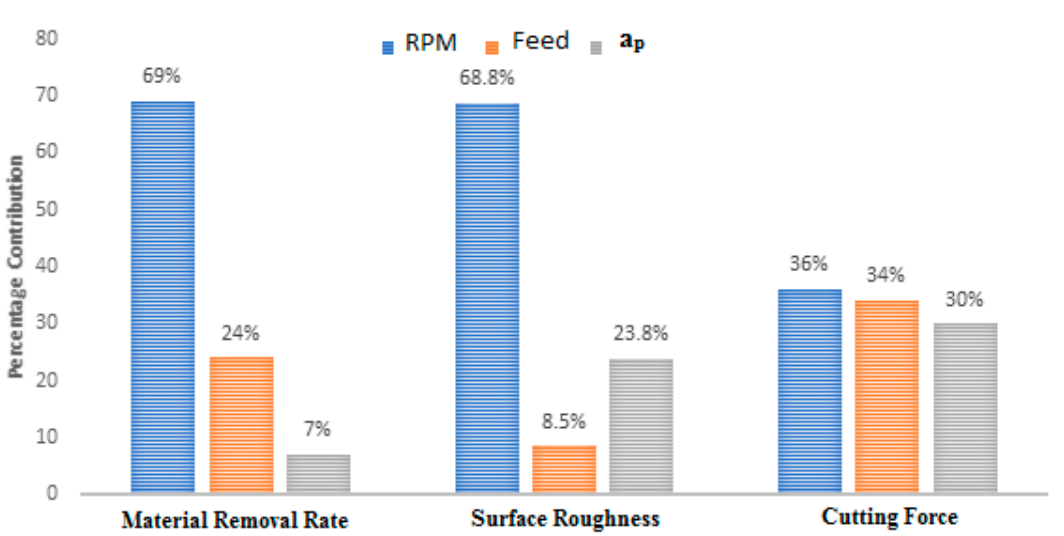
Table 6. Analysis of variance for cutting force (FC).